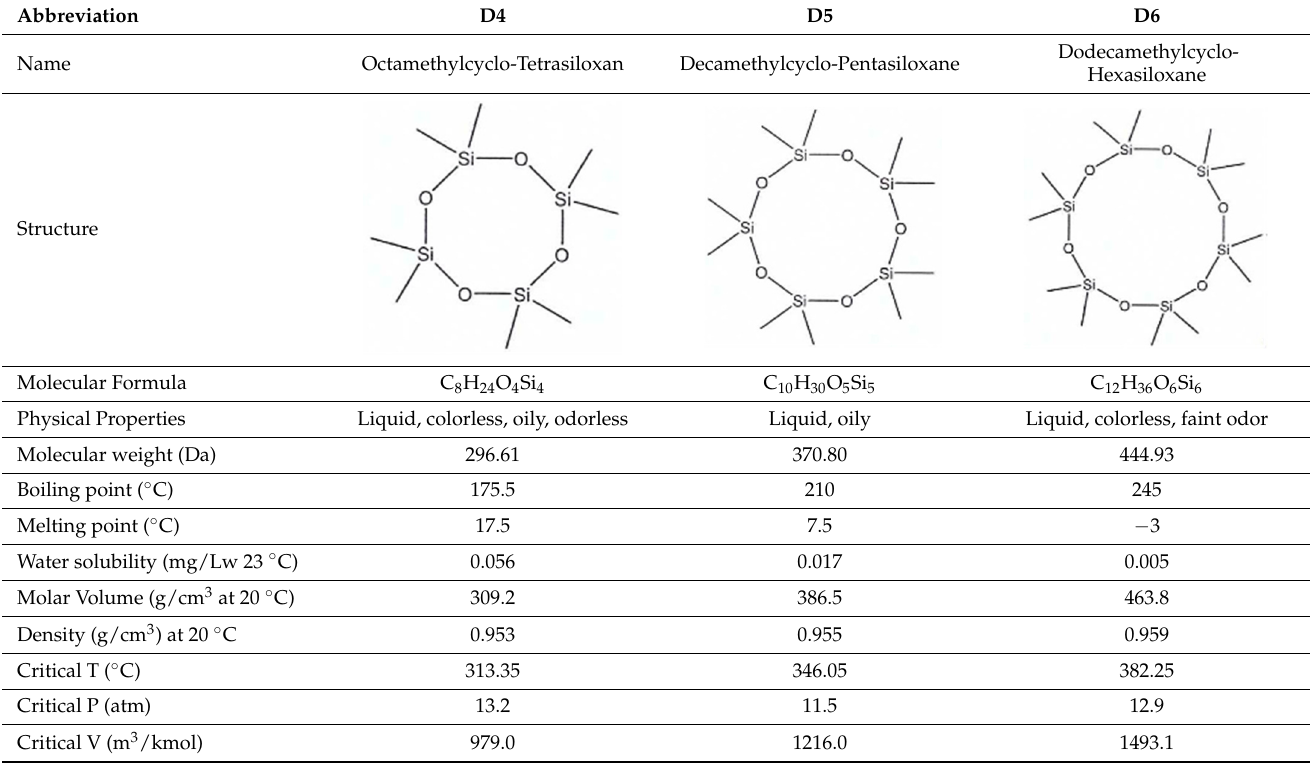
Table 1. Main chemical-physical characteristics of the siloxanes D4, D5, D6 [3].